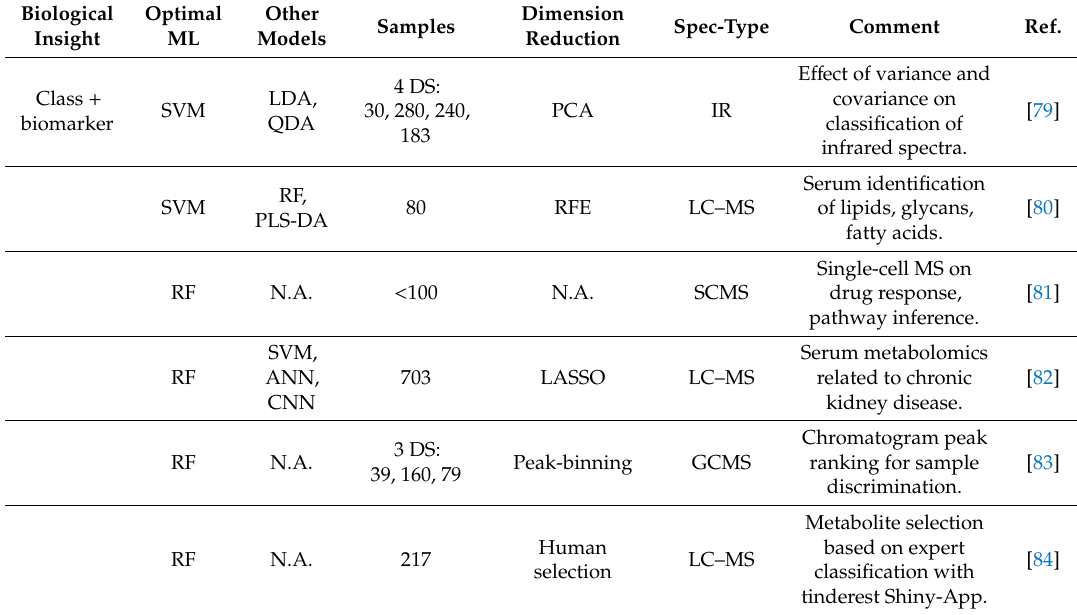
Table 4. Data to knowledge procedures with ML support published from 2019. In some cases, di ff